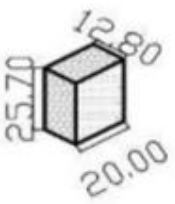
Figure 27. Dimensions of the specimen of compression (Author’s own, n.d.)